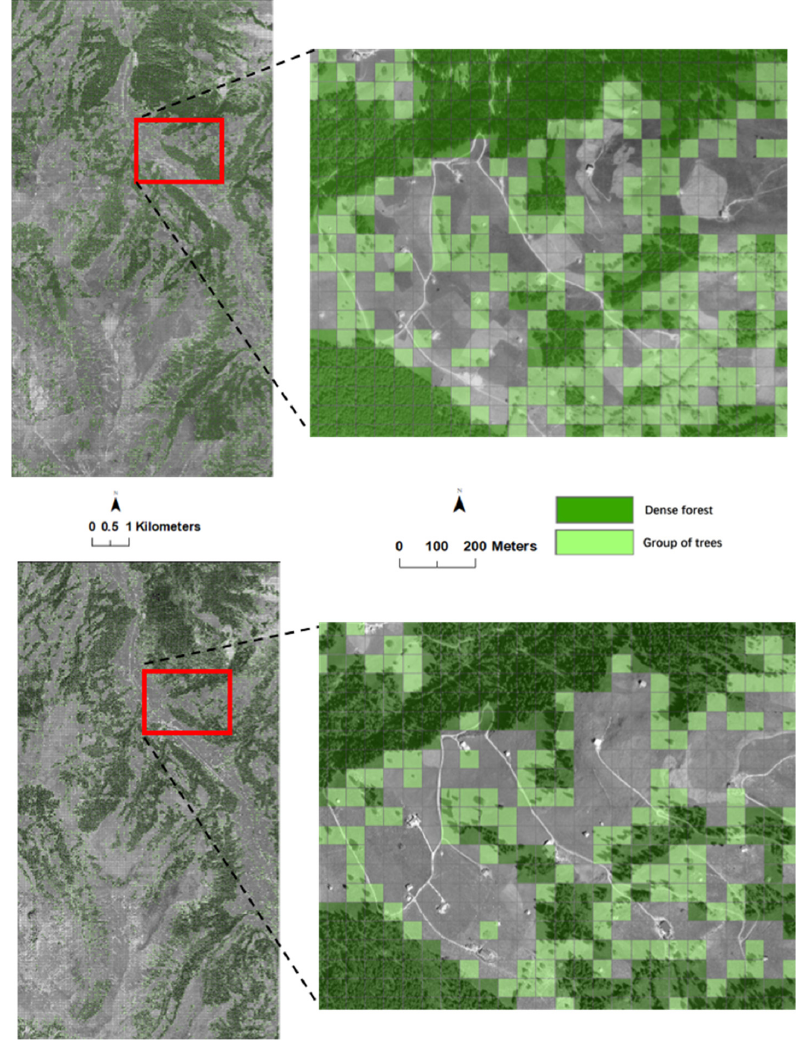
Figure 11. Classification result for study area 1 for time point T1 (images from 1980) ( top ) and time point T2 (images from 2010) ( bottom ). The class “other” belongs to the background areas and is not colored. The colored classification results are overlaid on the B&W aerial images for T1 and T2. Table 2. Agreement between classification and visual image interpretation for the three classes “dense forest”, “group of trees”, and “other”. Note that in study area 1 image patches from 2009 were used as training data and were therefore excluded from the agreement analysis.